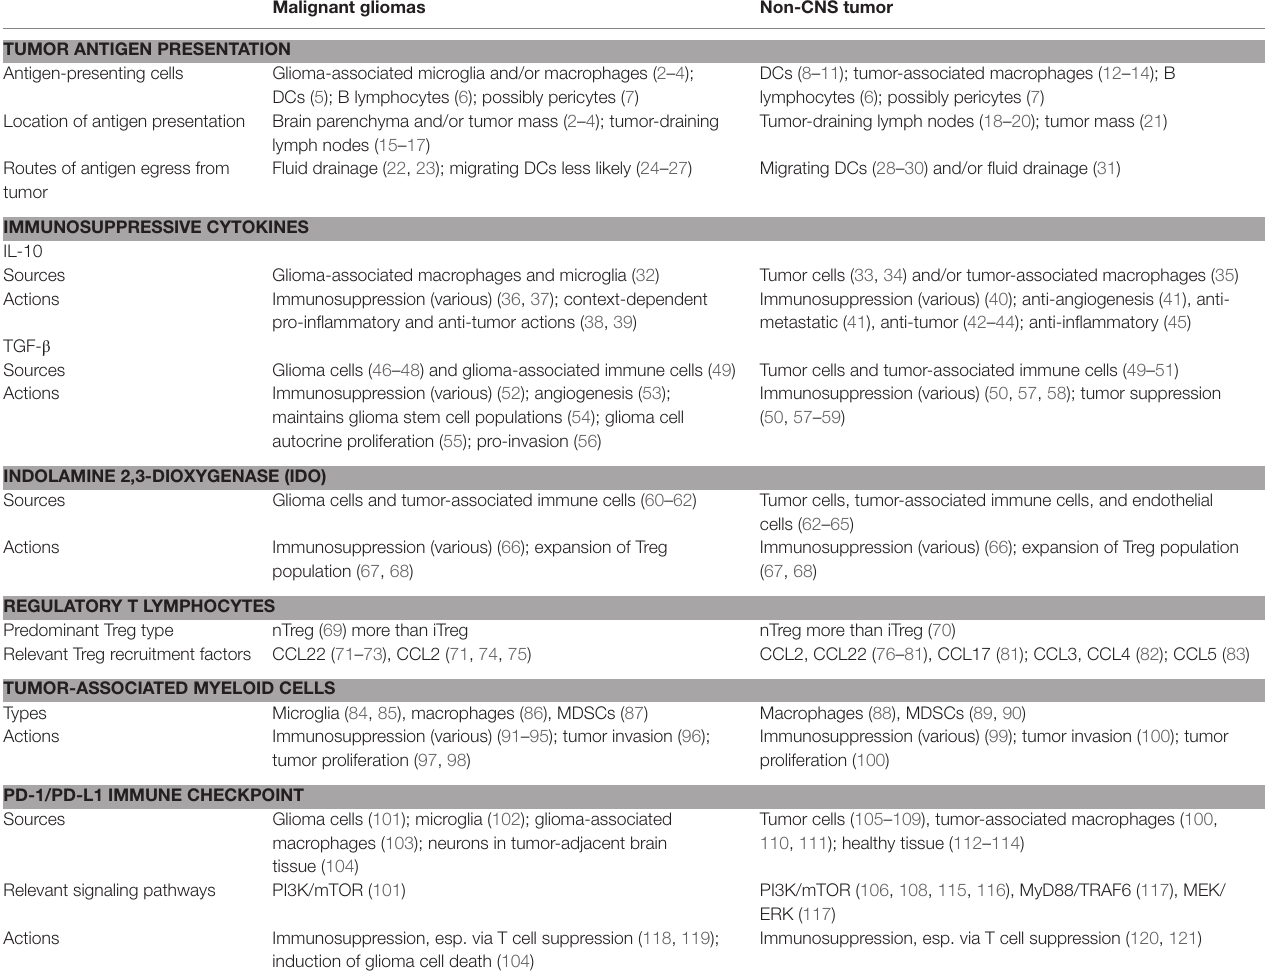
TABLe 1 | Key examples of immune-modulatory mechanisms shared between malignant gliomas and non-CNS